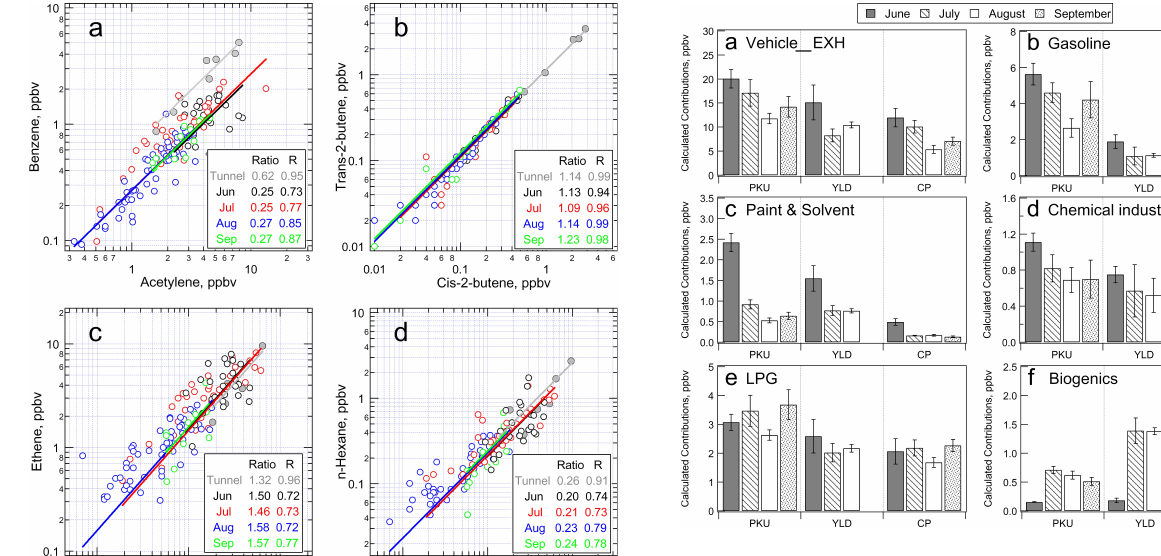
Fig. 5. Calculated contributions from major sources at the three sites: (a) vehicle EXH, (b) gasoline, (c) paint and solvent, (d) chemical industry, (e) LPG, and (f) biogenics in June, July, August, and